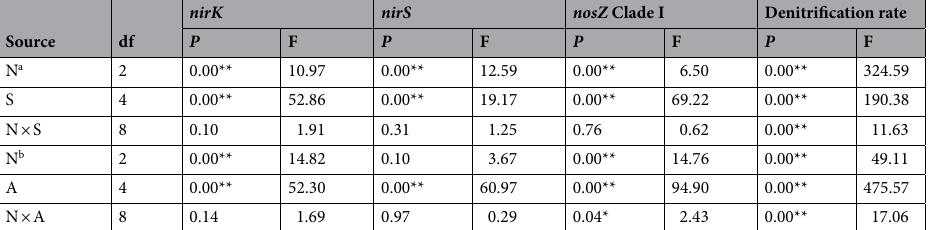
Table 2. P values and F values from two-way ANOVA of urea levels (N), salt gradients (S)/salt-alkali gradients (A) and their interaction (N × S/N × A) on denitrifying gene abundances and denitrification rates. N a and N b represent the effect of urea on the dependent variables when interacting with salt and alkali, respectively. Significance levels: * P < 0.05, ** P <